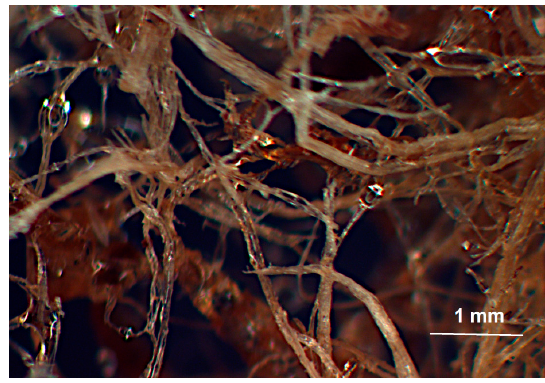
Figure 8. Optical Image of 10% Vinyester resin and Medium Density Fiberboard (MDF) fiber.